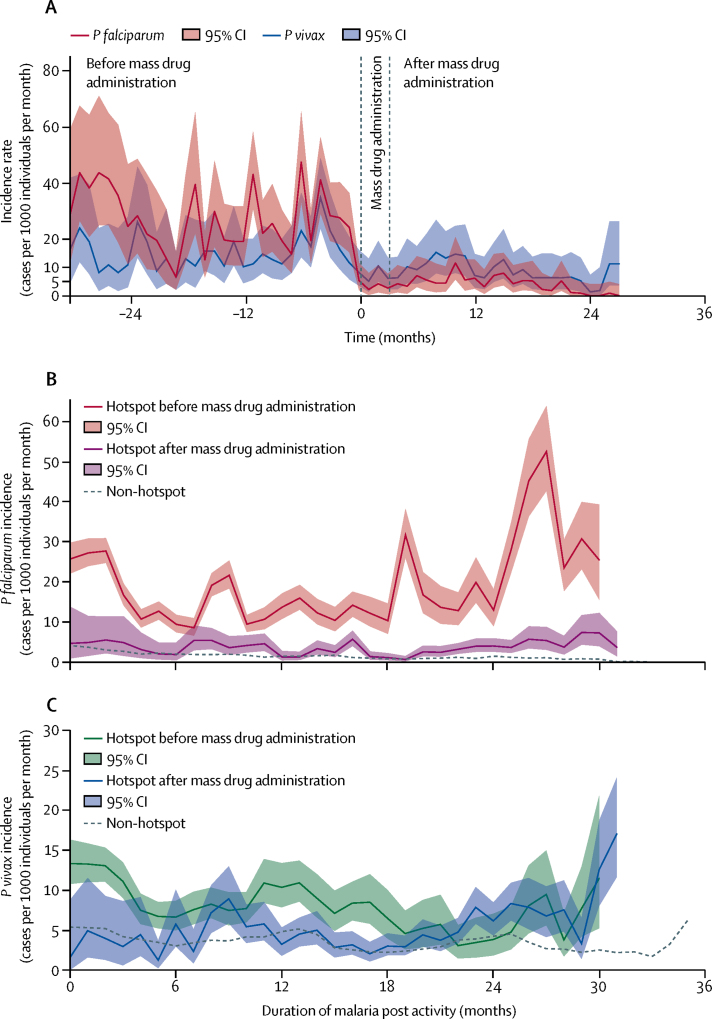
Mean Plasmodium falciparum and Plasmodium vivax incidence in hotspots before and after mass drug administrationData are (A) centred on the date of mass drug administration. Each hotspot contributes different lengths of follow-up before and after mass drug administration. The median follow-up before mass drug administration was 15 months (IQR 8–22), including addressed hotspots (median 12 months, 5–16, n=50) and hotspots remaining unaddressed (median 32 months, 25–33, n=18). The median follow-up after mass drug administration was 20 months (IQR 14–24, n=50). A marked decrease in P falciparum incidence after mass drug administration is observable, despite an increase in incidence around 15 months after mass drug administration. This increase is related to five hotspots (of 52 followed up to month 18) showing an incidence above 50 cases per 1000 individuals for 1 month during the second year after mass drug administration. This increase did not persist. Other graphs show incidence by duration since malaria post opening, according to before, or after, mass drug administration status for (B) P falciparum and (C) P vivax. Non-hotspot incidence trend (dashed line) is presented for reference. Different numbers of villages contributed to each estimate according to the timing of their mass drug administration.